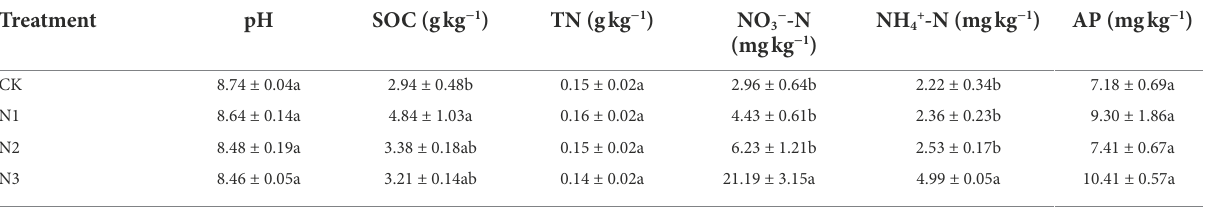
TABLE 1 Effects of N addition on soil properties.